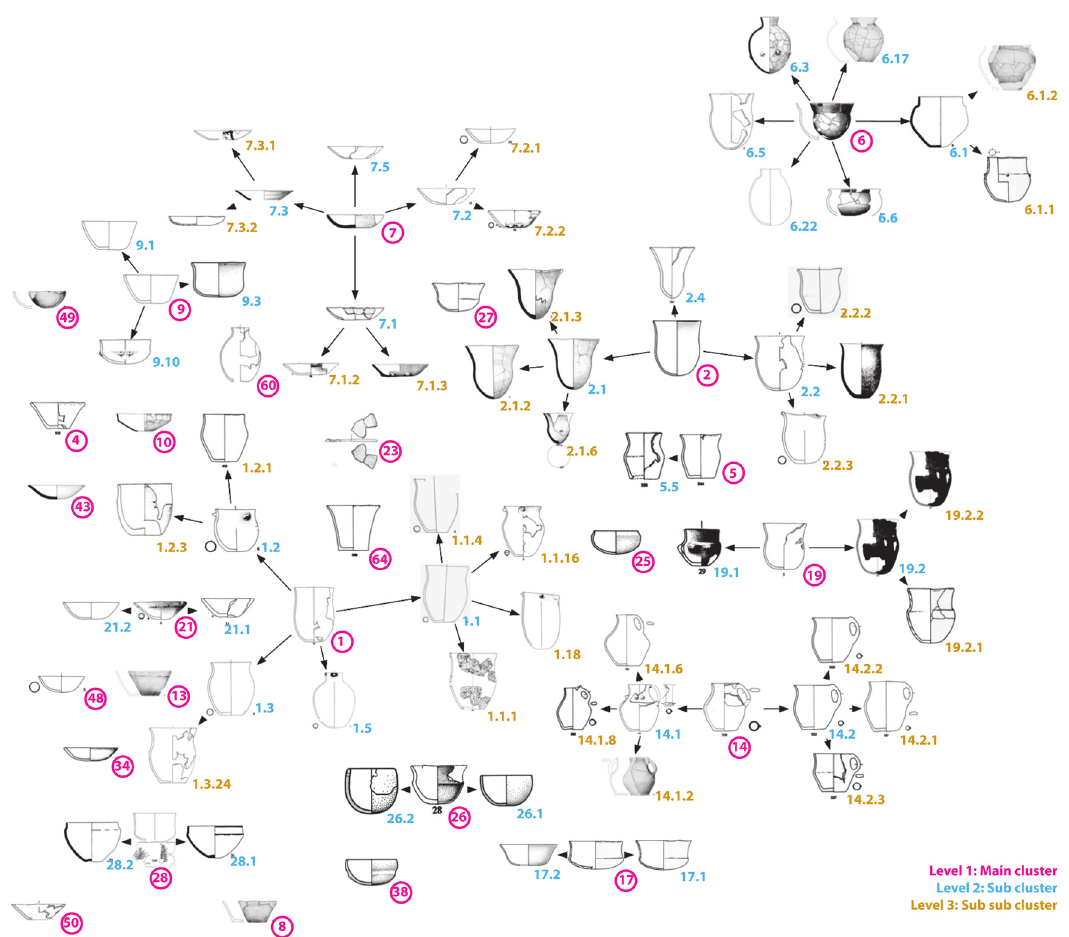
Figure 7: The clusters and their subcluster on three hierarchical levels, represented by the centroid vessels, displayed as hierarchical network ( fi gure: M. Hinz and C. Heitz, Copyright of pottery drawings: doi: 10.5281/zenodo.7258694. )